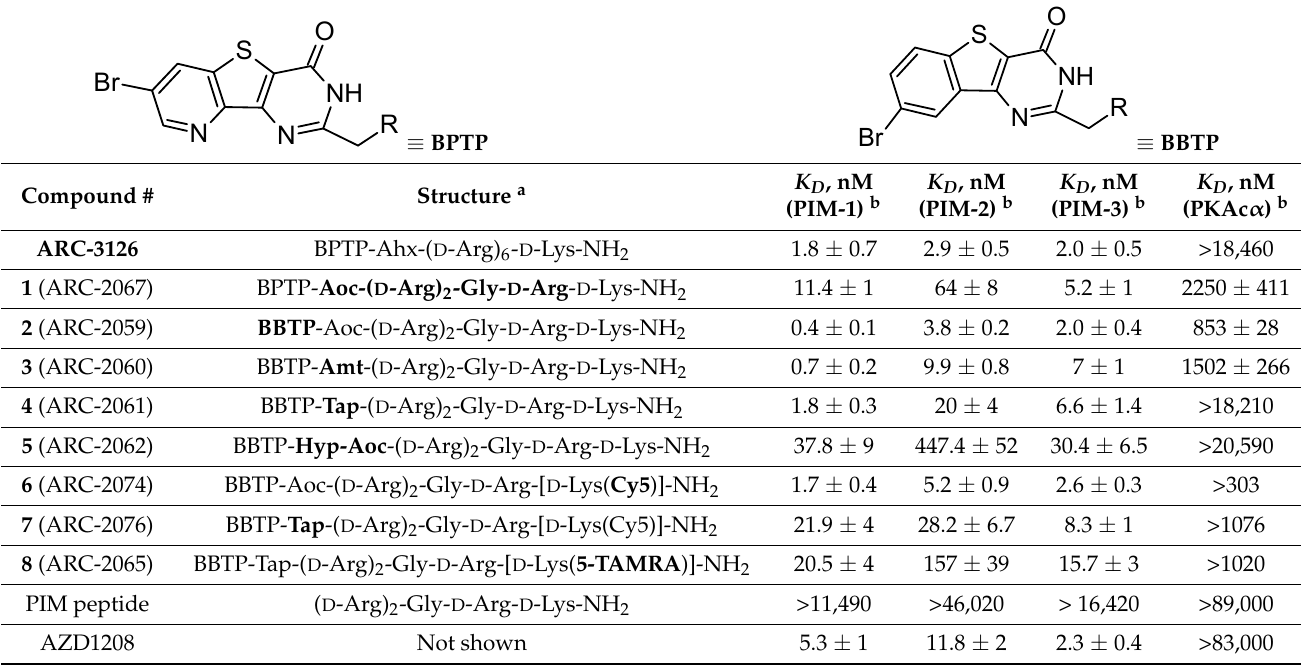
Table 2. Structures of tested ARC inhibitors and their affinities toward PIM kinases and PKAc α .